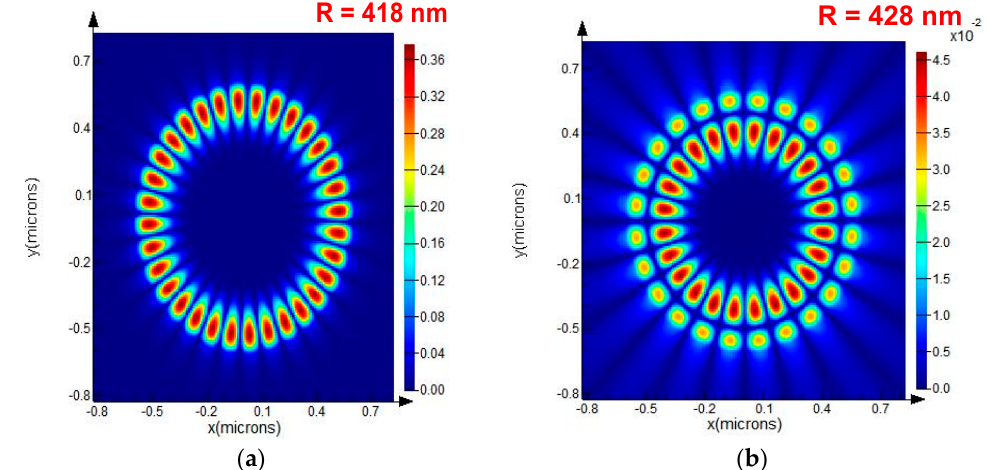
Figure 4. ( a ) Magnetic field of the WGM resonator in the first order ( R = 418 nm); ( b ) Magnetic field of the WGM resonator in the second order ( R = 428 nm).